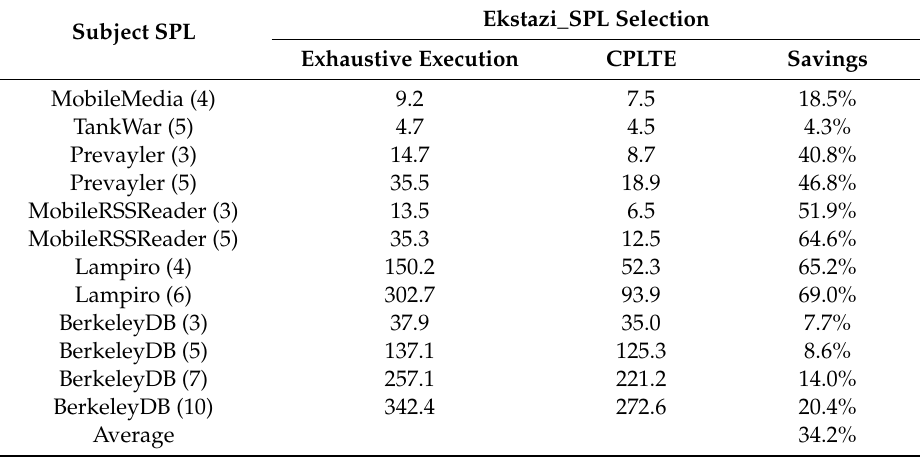
Table 6. Average end-to-end time savings (in seconds) of CPLTE when the Ekstazi_SPL selection is